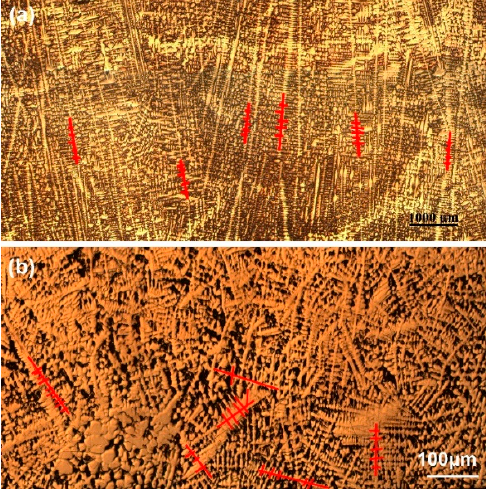
Figure 17. Morphology of macrostructure of slab. ( a ) Columnar zone; ( b ) CET zone.